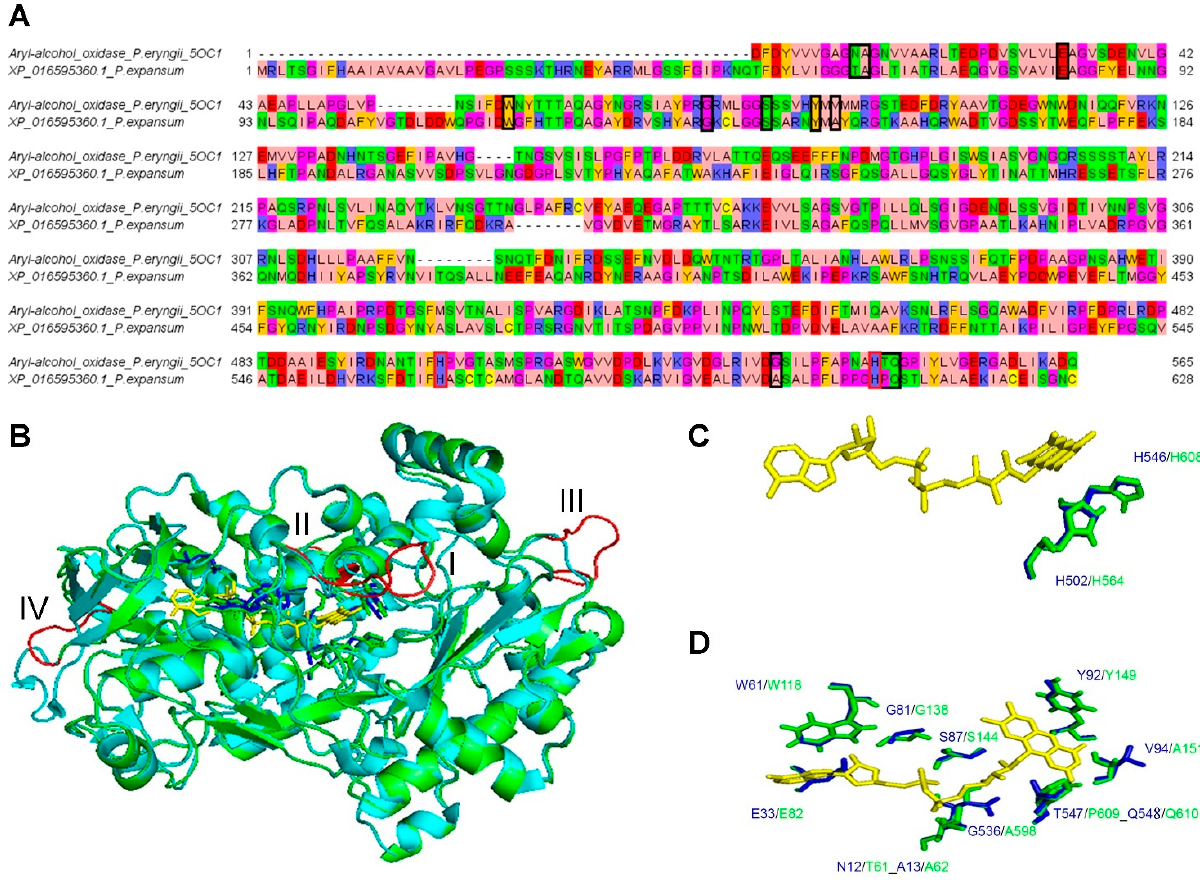
Figure 3. Sequence-structure alignment of P. expansum GMC oxidoreductase superimposed to P. eryngii aryl-alcohol oxidase. Panel A : Black boxes indicate the aligned amino acids involved in the FAD ligand binding, whereas red boxes indicate the aligned amino acids involved in the substrate catalytic binding site. Panel B : 3D comparative model of P. expansum GMC oxidorectase built by using P. eryngii AAO as a protein template . P. expansum GMC oxidoreducate is reported in green cartoon representation whereas the AAO crystallized structure from P. eryngii is reported in cyan cartoon representation. Loops that show a different orientation between the 3D comparative model and the crystallized superimposed structure are reported in red cartoon. FAD crystallized in AAO superimposed to the P. expansum GMC oxidoreductase is reported in yellows sticks. Residues within 4 Å from FAD within AAO and the P. expansum GMC oxidoreductase are reported in blue and green sticks, respectively. Panel C : zoomed view of the superimposed AAO and the P. expansum GMC oxidoreductase histidine residues (within 4 Å from FAD) proposed to be involved in the binding of GMC oxidoreductase substrates. Panel D : zoomed view of the superimposed AAO and the P. expansum GMC oxidoreductase residues within 4 Å from FAD (His residues are excluded in this panel for a simplified view).